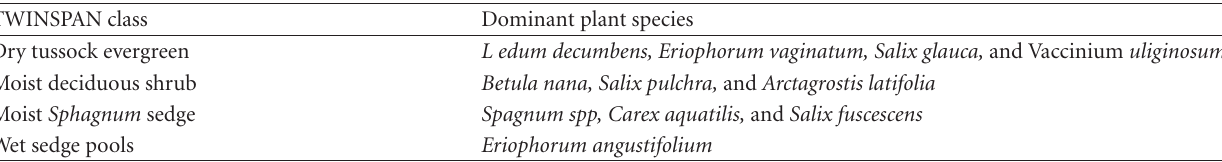
Table 4: TWINSPAN vegetation classes and dominant plant species per class. TWINSPAN